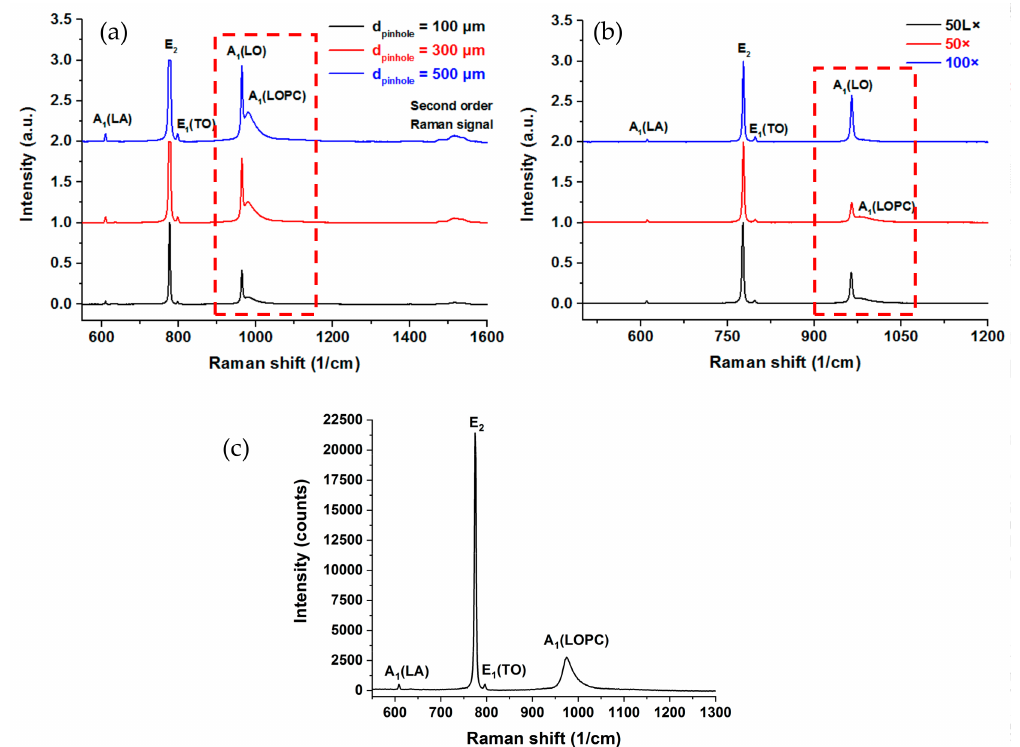
Figure 3. Raman spectra of sample Q1 for di ff erent pinhole sizes and di ff erent lenses (the spectra are normalized to E 2 mode intensity) and the single spectrum of heavily doped 4H–SiC substrate: ( a ) Single spectra of Q1 with a confocal pinhole of 100 µ m, 300 µ m, and 500 µ m using a 50L × lens and grating of 1800 lines / mm; ( b ) Single spectra of Q1 with lenses of 50L × , 50 × , and 100 × using a 100 µ m pinhole, and grating of 2400 lines / mm; ( c ) Single spectrum of 4H–SiC substrate without an epitaxial layer with lens of 50L × , a 100 µ m pinhole, and grating of 1800 lines / mm.